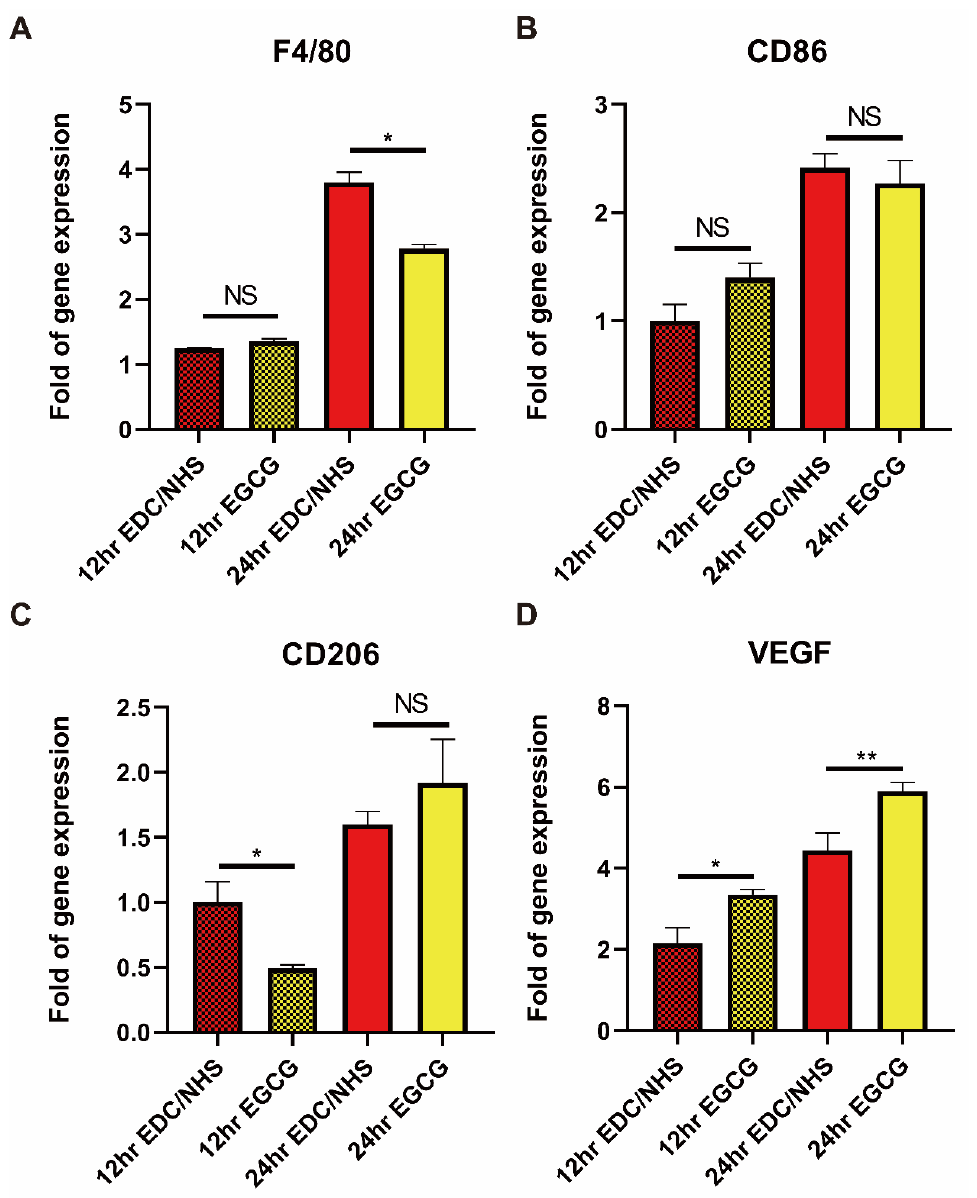
Figure 7. qPCR results of full-thickness skin defects in vivo at 12 and 24 h after implantation with EDC/NHS-Col and EGCG-EDC/NHS-Col. Marker genes included F4/80 ( A ), CD86 ( B ), CD206 ( C ), and VEGF ( D ). The macrophages were recruited and proliferate more in 24 h ( A ); the same trend could also be reflected in macrophage phenotypes (B&C); higher levels of angiogenesis-related expression markers VEGF showed in 24 h ( D ). NS = no significance, * p < 0.05, ** p < 0.01, one-way ANOVA with Tukey’s multiple comparison testing, n = 3 in each